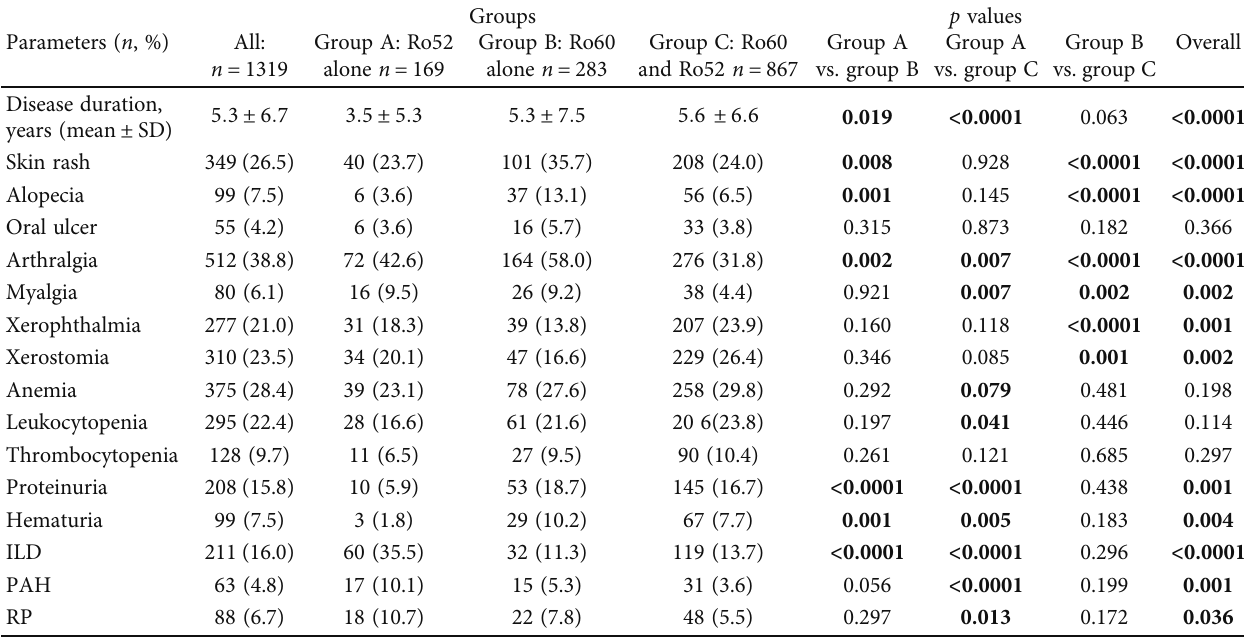
Table 3: Comparison of clinical features in patients with connective tissue diseases.